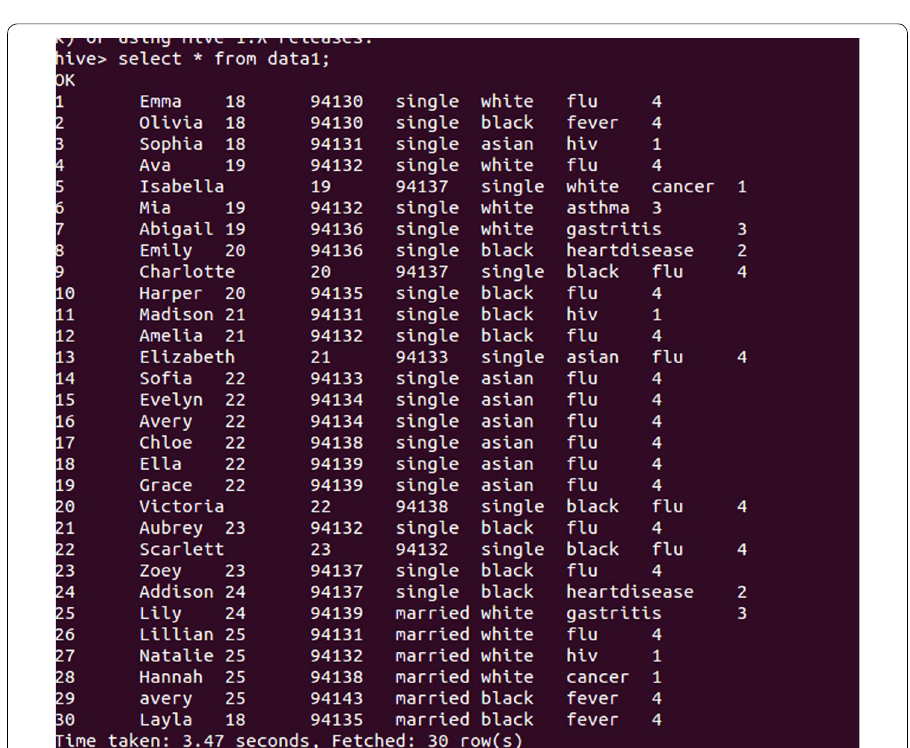
Fig. 5 Dataset before sensitivity calculation